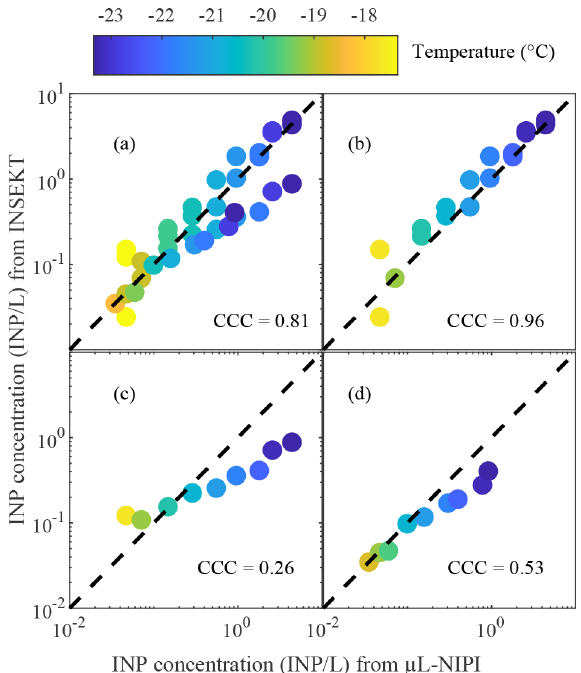
Figure 10. INP concentration measurements from INSEKT and µL-NIPI compared to one another for 28 March. Point color rep- resents the ice nucleation temperature. The panels include (a) the full measurement set, (b) INSEKT day and morning (red and or- ange bars in Fig. 9) versus µL-NIPI afternoon measurements (dark green in Fig. 9), (c) INSEKT afternoon (light green in Fig. 9) ver- sus µL-NIPI afternoon measurements (dark green in Fig. 9) and (d) INSEKT night (dark blue in Fig. 9) versus µL-NIPI night measure- ments (light blue in Fig. 9). In each case the dashed line represents the 1 : 1 line, and the concordance correlation coefficient (CCC) is